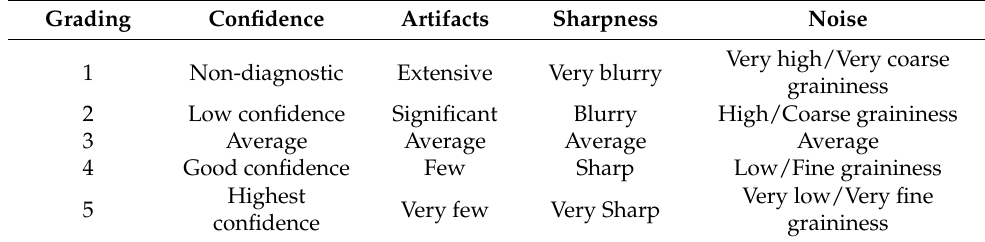
Table 2. Five-point Likert-scale used for qualitative image